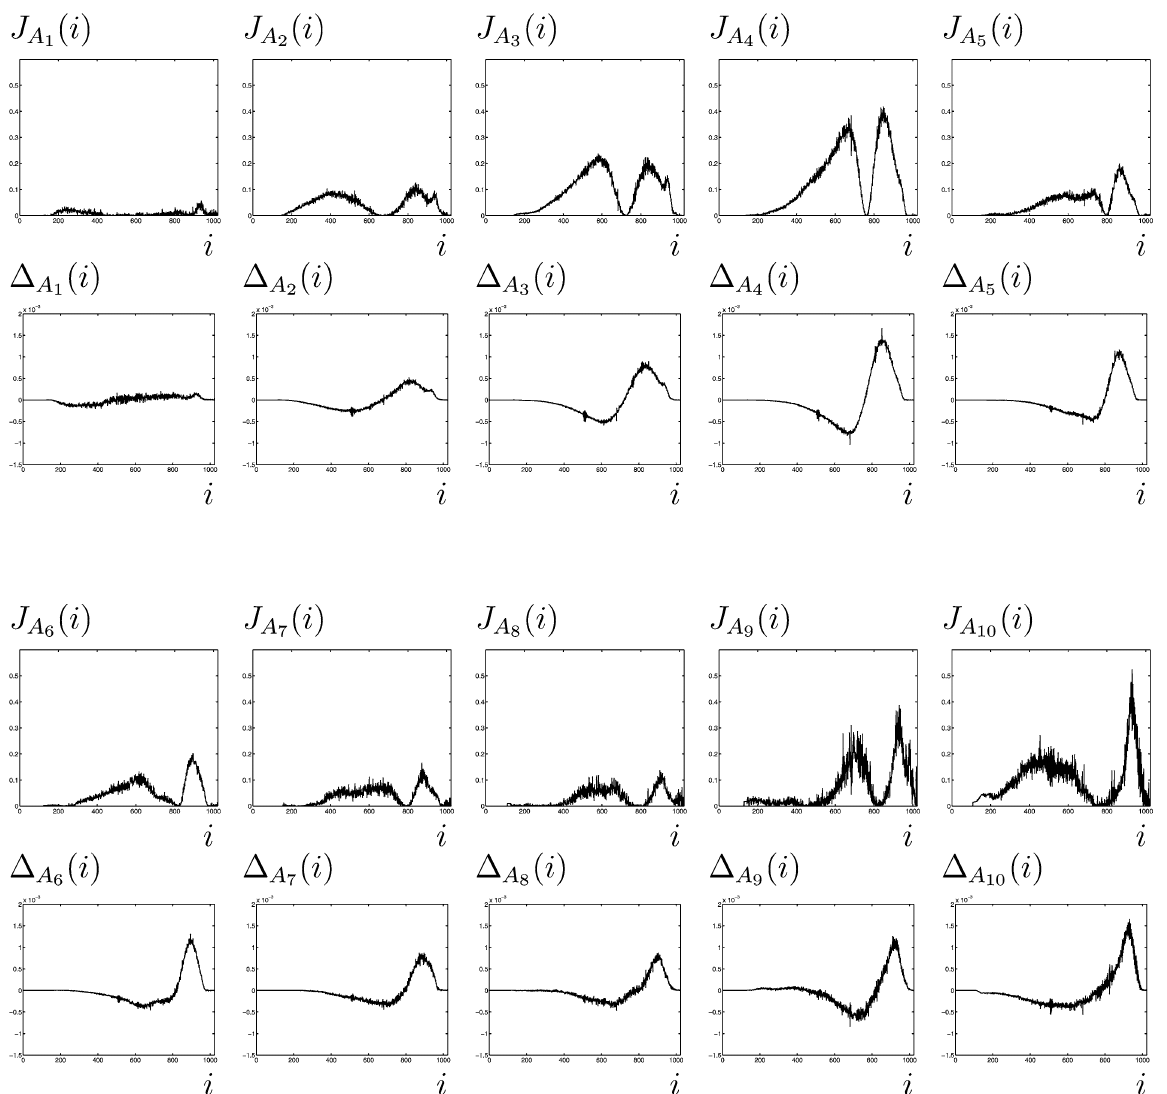
Fig. 3. The gray level distribution Mahalanobis class distance vector J A | ω ∆ A a ( i 1 , ω 2 ) between the good ω 1 and poor ω 2 prognosis classes of early ovarian cancer, computed from nuclei within each area interval A a , a = 1, ... ,10. The positive (negative) values in the difference vectors correspond to gray levels i that are more (less) probable for the good prognosis class compared to the poor prognosis class. The vectors were computed from the complete non-standardized